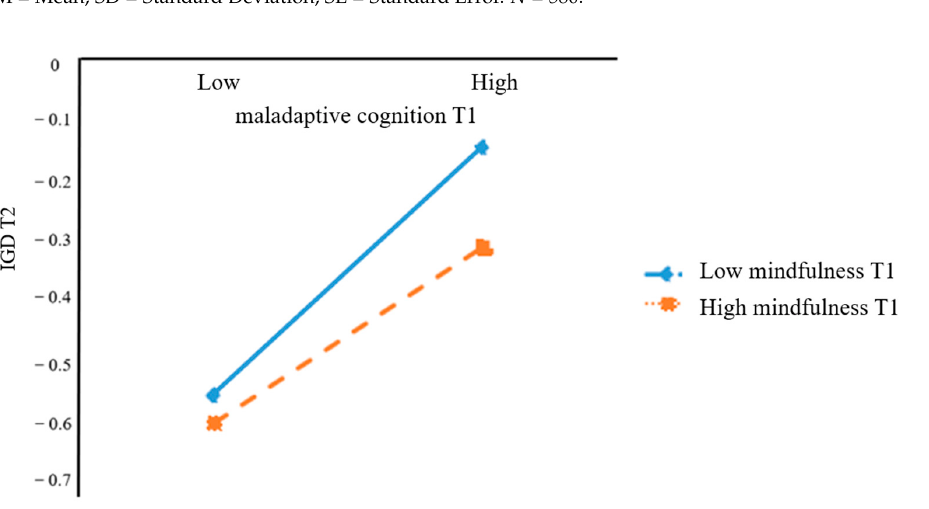
Figure 2. The Moderating Role of Mindfulness in the Relationship Between Maladaptive Cognition and IGD. Note: IGD = Internet Gaming Disorder; T1 = at Wave 1; T2 = at Wave 2. Mindfulness T1 was divided into two groups (high mindfulness and low mindfulness), defined as plus or minus